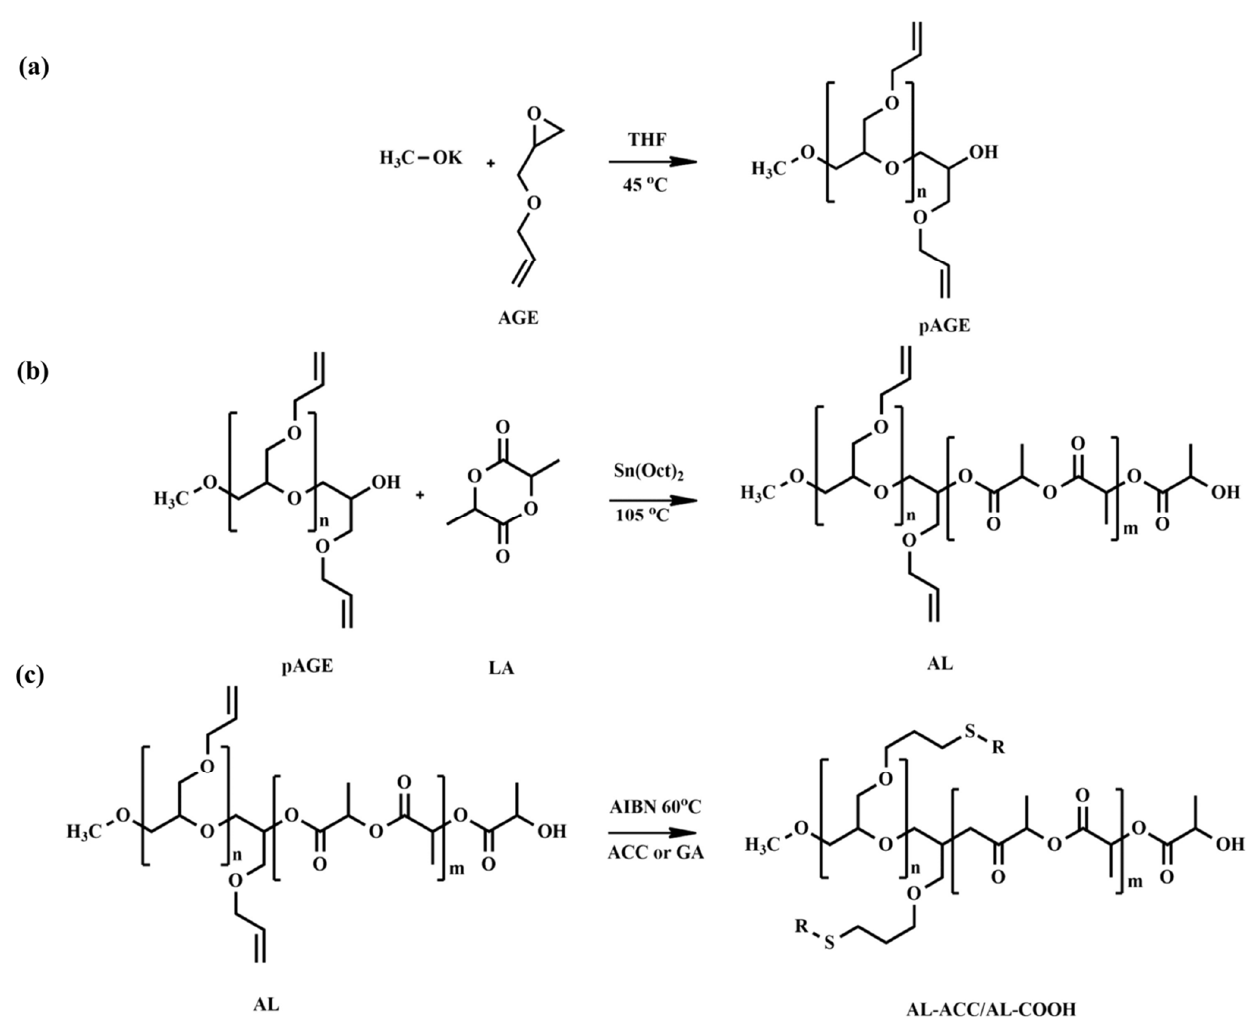
Figure 1. The scheme of synthesis of the pAGE-PLA copolymer. ( a ) Anionic polymerization of AGE, ( b ) coordination polymerization of LA initiated by pAGE, and ( c ) functionalization of AL with ACC or tGA (where R is ACC or -CH 2 -COOH moiety) as proposed by Kost et al. Reprinted with permission from [58]; published by Elsevier, 2021.